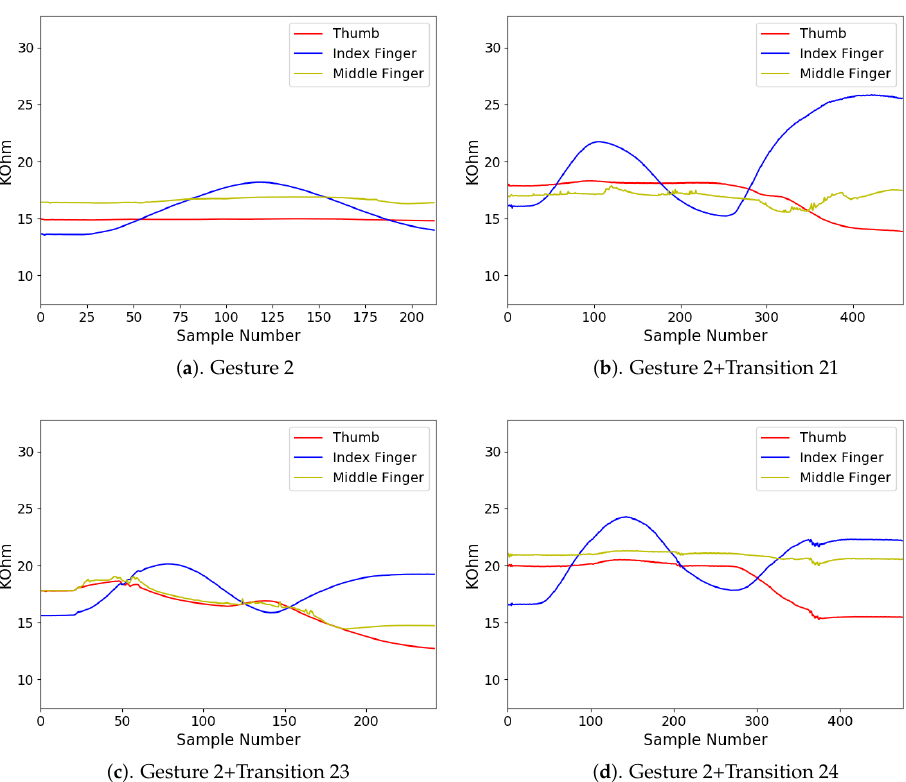
Figure 15. The measured sensory data produced by flex sensors of the smart glove for gesture class 2.